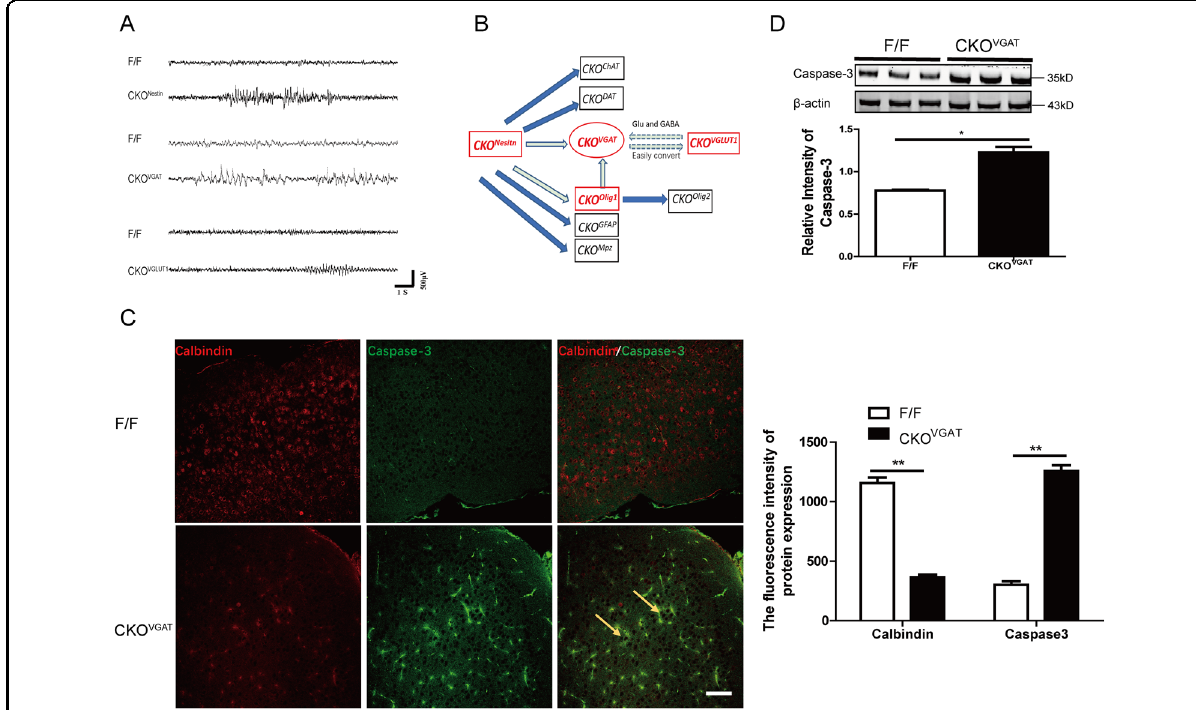
Fig. 3 Fgf9 CKO in GABAergic neurons induces neuronal apoptosis. A EEG recordings of other types of Fgf9 CKO mice associated with GABAergic neurons ( CKO Nestin , CKO VGAT , and CKO VGLUT1 ) showing spontaneous seizures. B Schematic diagram describes that CKO Fgf9 in many different cell types. CKO mice with epilepsy indicated in red, and no seizure CKO mice indicated in black. C Caspase-3 colocalized with GABAergic neurons (calbindin) in the cortex of CKO VGAT mice by immunostaining. The density of calbindin (1156 ± 45.6 vs 364 ± 22.3, P = 0.0054) or caspase-3 (302± 28.1 vs 1324 ± 25.2, P = 0.0063) in the cortex of F/F and CKO VGAT mice. Scale bars, 100 μ m. D Western blot analysis demonstrates higher caspase-3 expression in the cortex of CKO VGAT mice than in controls.